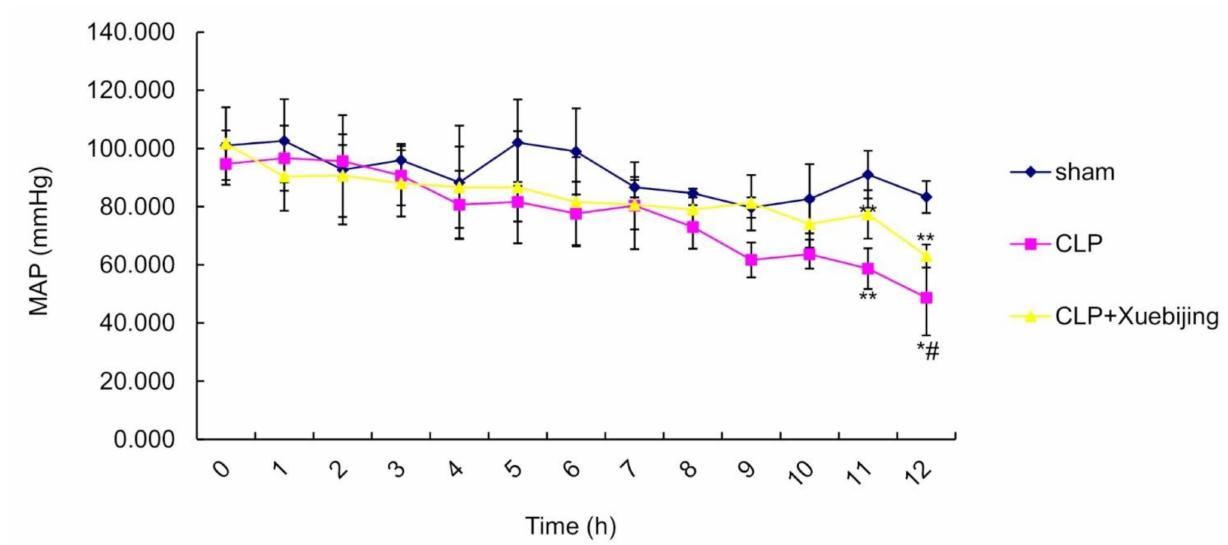
Figure 1. Xuebijing administration restored the mean arterial pressure (MAP) in cecal ligation and puncture (CLP)-induced septic rats. Rats were randomly divided into sham, CLP, and CLP + Xuebijing groups (n = 25/group). Each group was further divided into 2, 4, 6, 8, and 12 h subgroups (n = 5/subgroup). The MAP values were recorded in 3 randomly selected rats from the 12 h subgroup. Data are expressed as the mean ± standard deviation (SD). * p < 0.05, ** p < 0.01 vs. sham group; # p < 0.05 vs. CLP group; n = 3. MAP, mean arterial pressure; CLP, cecal ligation and